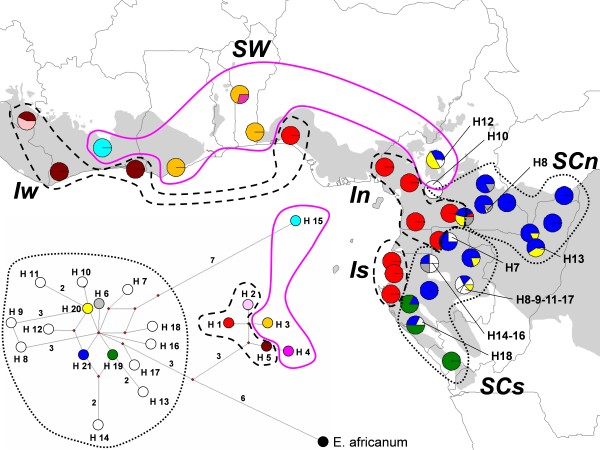
Distribution and median-joining network of haplotypes of the pDNA inter-genic fragment trnC-petN1R, and delimitation of the distribution of major and minor gene pools as inferred from nSSRs (pink line: SW gene pool, dashed line: SCn and SCs gene pools; dotted lines: Iw, In, Is gene pools). Rare haplotypes are indicated directly on the map by a number. Small dots on the haplotype network indicate ancestral nodes or unsampled haplotypes. Branch lengths are proportional to the number of mutations (numbers on branches where > 1 mutation). Haplotypes associated with each of the three major gene pools are encircled on the haplotype network, except that haplotypes H12, H20 and H21, most typical of SC, are also found in SW populations from Northern Cameroon.